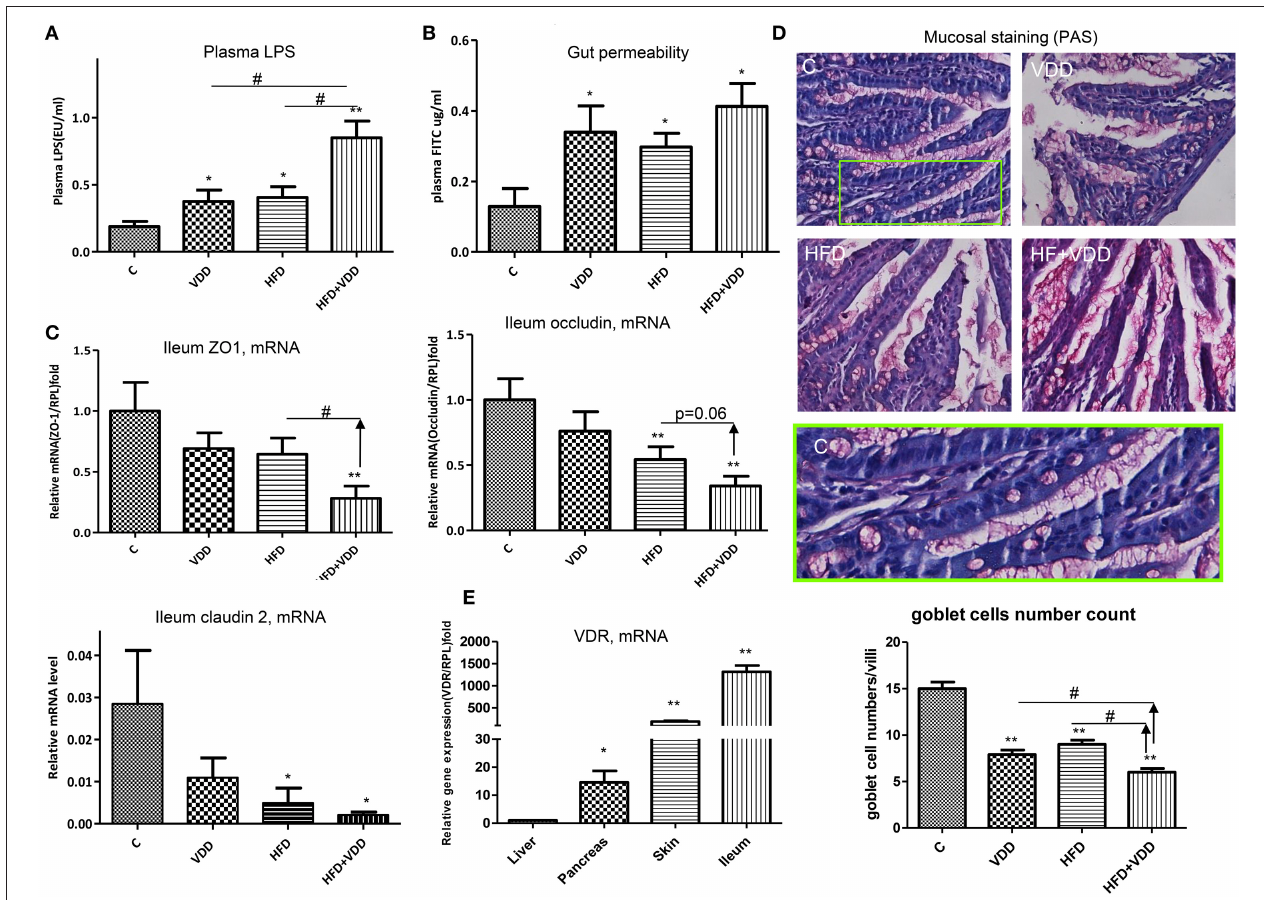
FIGURE 3 | Vitamin D maintains intestinal homeostasis. The animal feeding conditions are described as in Figure 1 . (A) Plasma LPS levels were measured by a Limulus Amebocyte Lysate kit. (B) Gut permeability was determined by fluorescein isothiocyanate (FITC)-dextran presented in plasma after oral gavage administration. (C) Expression of ZO-1, occluding, and claudin 2 in ileum region was determined by RT-qPCR analysis. (D) Periodic Acid/Schiff (PAS) staining. Green box highlights the mucosa and goblet cells in the control. (E) Expression of VDR in the ileum, skin, pancreas, and liver by the mice was determined by RT-qPCR analysis. Data represent two independent experiments ( n = 6–10 mice/group for each measurement). Error bars represent the SEM of samples within a group. * p ≤ 0.05, ** p ≤ 0.01 (Student’s t -test). The arrows indicate the impact of dietary vitamin D on intestinal integrity and plasma endotoxin. # indicates the impact of vitamin D.